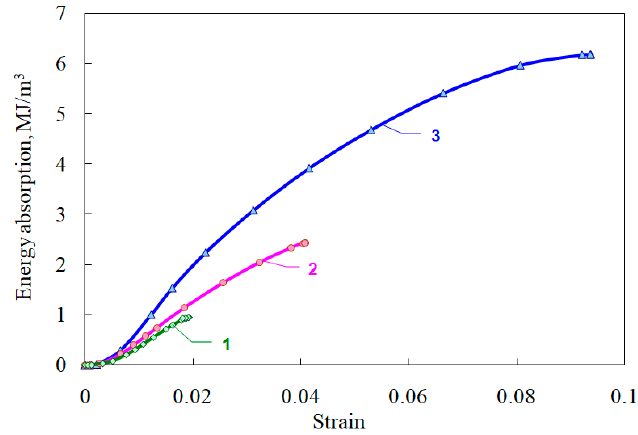
Figure 9. Energy absorption of ceramics.